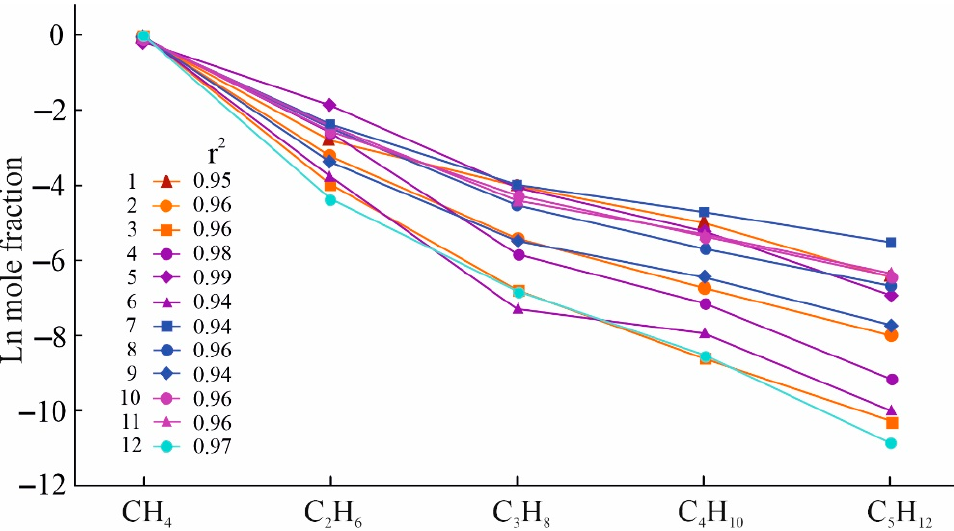
Figure 5. Molecular–weight distributions of alkanes in the rocks of peralkaline complexes. Khibiny massif: (1) Carbonatite complex, (2) foidolites, (3) foyaite; Lovozero massif [27]: urtite (4) and loparite malignite (5) of horizon II-4 (upper part of the Layered complex of the Lovozero massif), (6) foyaite of the series V (lower part of the Layered complex of the Lovozero massif); Ilímaussaq massif [31]: (7) lujavrite, (8) kakortokite, (9) naujaite; Strange Lake complex [2]: (10) “fresh” pegmatite, (11) altered pegmatite; Kiya–Shaltyr massif (unpublished data from A. Petersil’e): (12) urtite. r 2 —coefficients of determination to best ‐ fit lines.